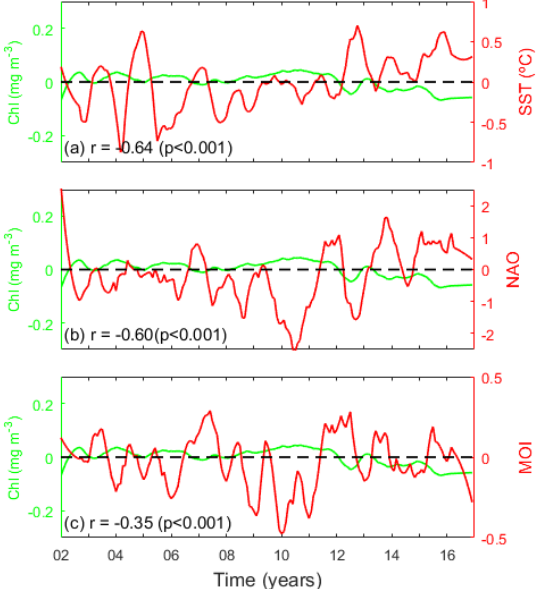
Figure A3. Relationship between coastal pelagic chlorophyll (chl anomalies, green lines) and (a) SST anomalies, (b) NAO index, and (c) MOI index (red